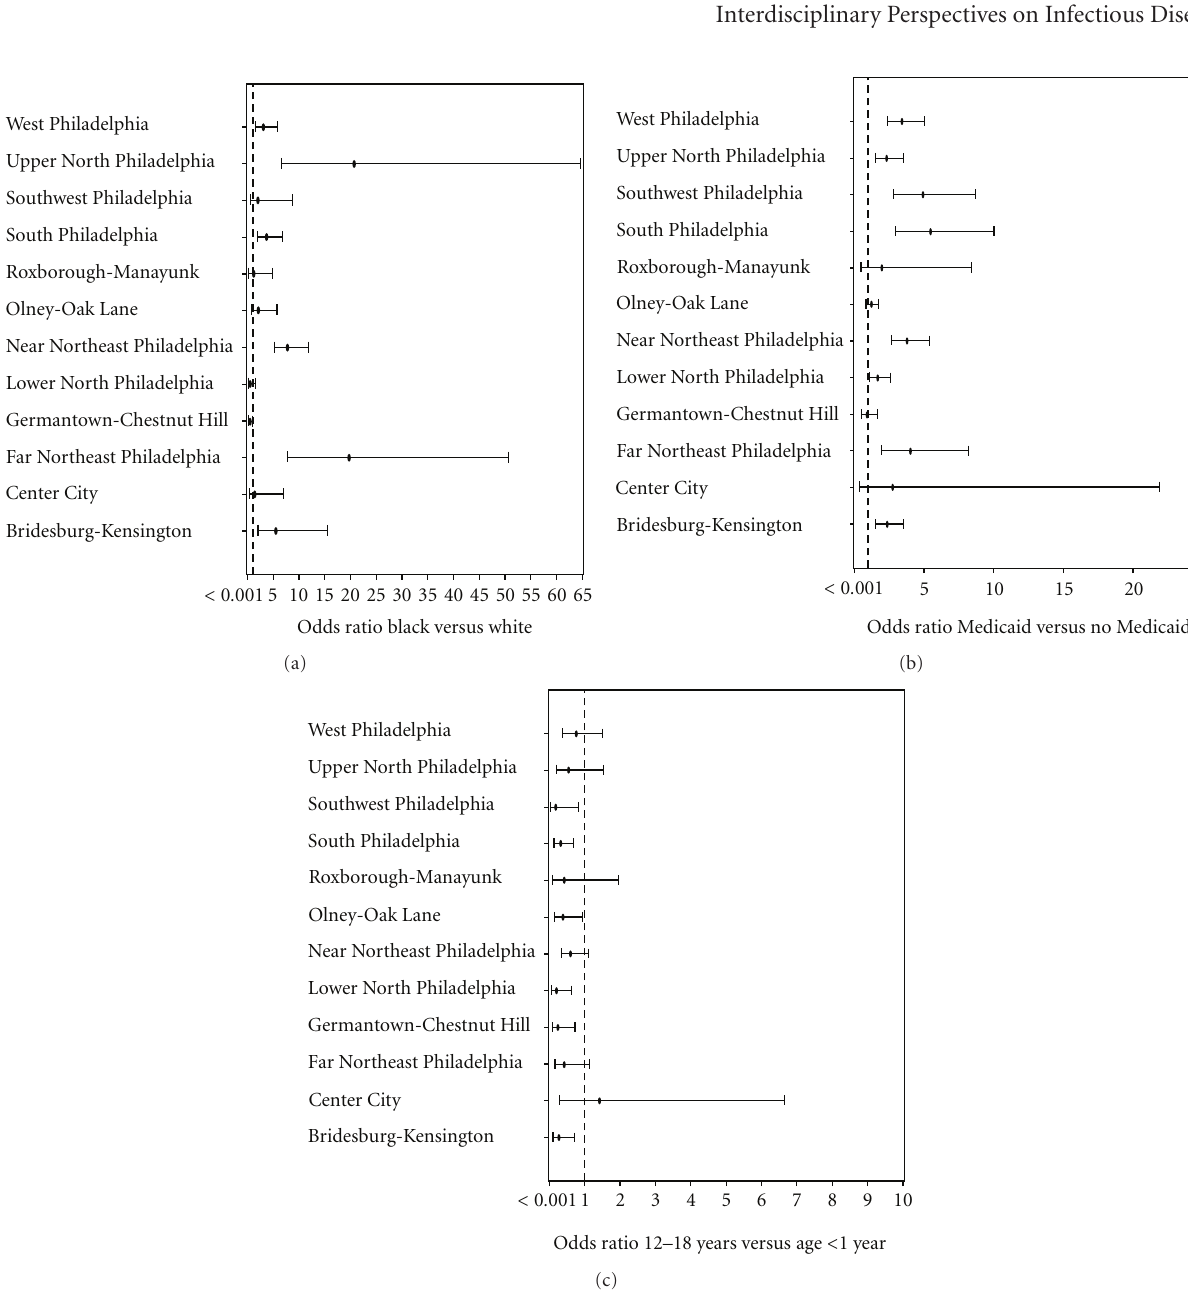
Figure 3: (a) Odds ratios for race (Black versus White) comparing the CHOP versus community populations by neighborhood, Philadelphia County. (b) Odds ratios for Medicaid (Medicaid versus no Medicaid) comparing the CHOP versus community populations by neighborhood, Philadelphia County. (c) Odds ratios for age (12–18 years versus < 1 year old) comparing the CHOP versus community populations by neighborhood, Philadelphia